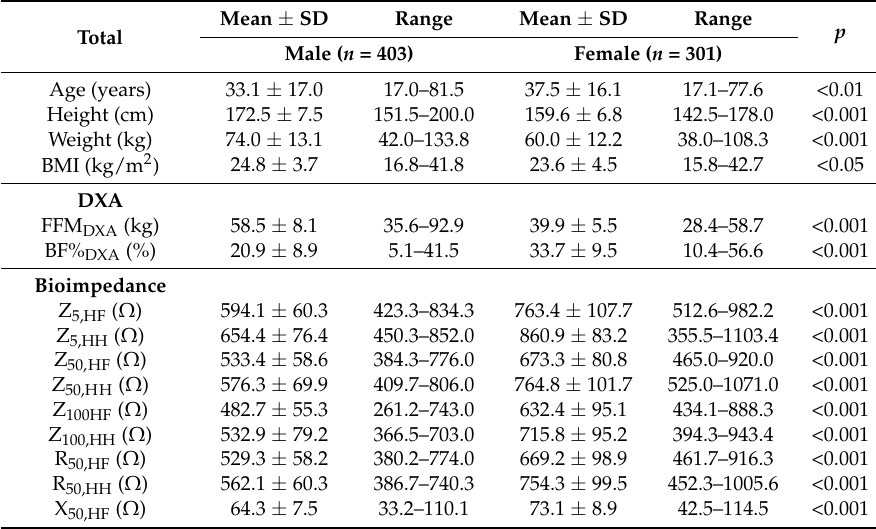
Table 1. General physical characteristics and body composition data for male and female